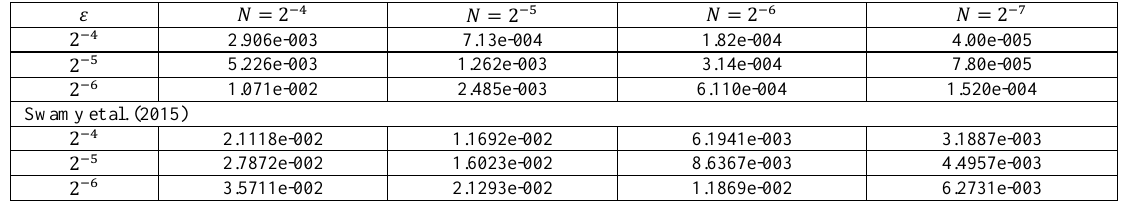
Table 2. The maximum absolute error of Example 1 for 𝛅 = 𝟎.